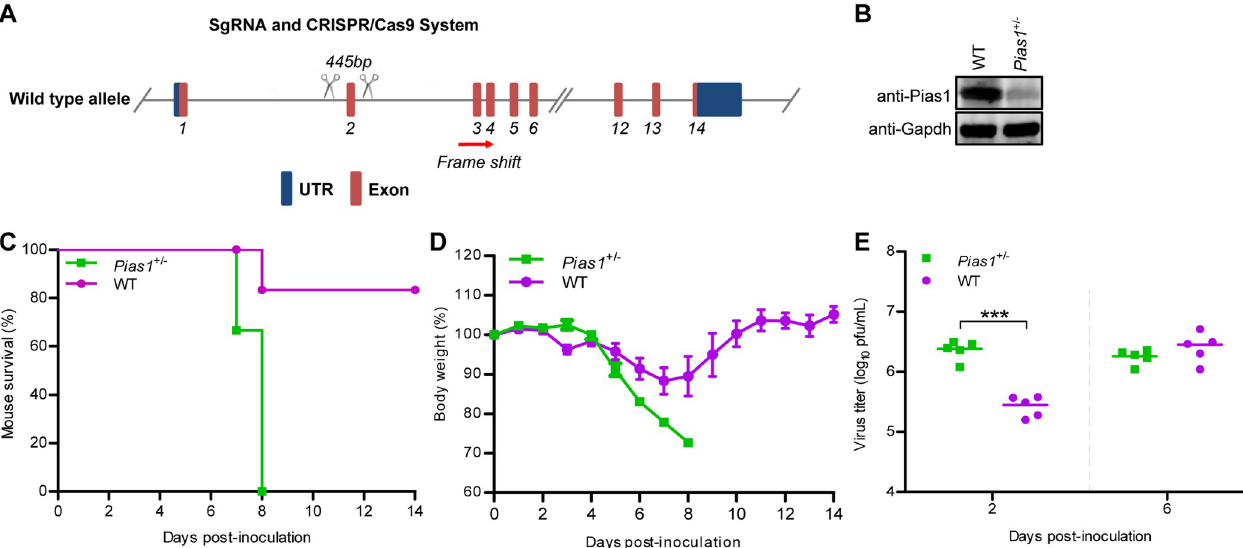
Fig 9. Pias1 inhibits IAV replication and virulence in mice. (A) Schematic illustration of the strategy used to generate Pias1 +/- mice. Two sgRNAs were designed to delete exon 2 of the Pias1 gene. (B) The genotype of Pias1 +/- mice was verified by western blotting with a rabbit anti-PIAS1 pAb. (C) Survival of WT and Pias1 +/- mice (n = 6 per group) after intranasal infection with WSN (H1N1) virus (1.2 × 10 4 PFU/mouse). (D) Body weight changes of WT and Pias1 +/- mice (n = 6 per group) after intranasal infection with WSN (H1N1) virus. (E) Titers of WSN (H1N1) virus in the lungs of WT and Pias1 +/- mice (n = 5 per group) on days 2 and 6